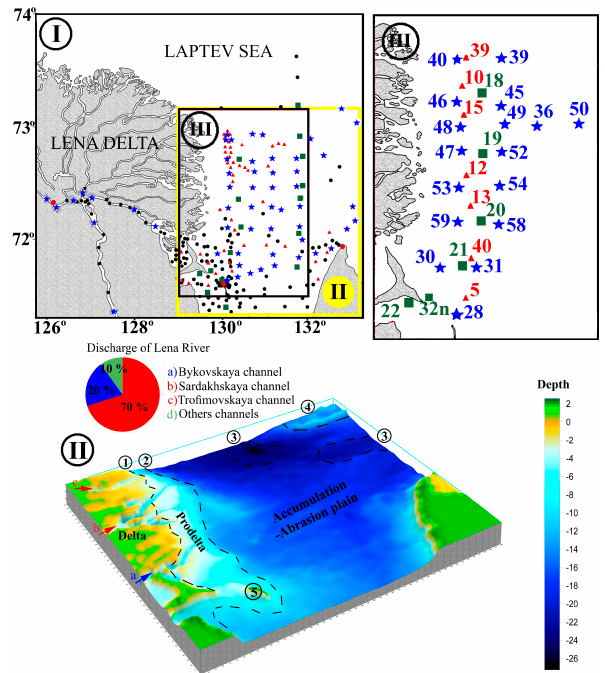
Fig. 1. Study area. I. Location of oceanographic stations from 1999 to 2008 years (black dots – oceanographic stations, red dots - coast observations). II. Flow chart of geomorphological structure of the Buor-Khaya Gulf: 1 – marine margin of delta, 2 – prodelta foot, 3 – accumulative plain, 4 – relict of subaerial land forms, 5 – Muostakh Island. III. Oceanographic station transects of vertical SPM and salinity